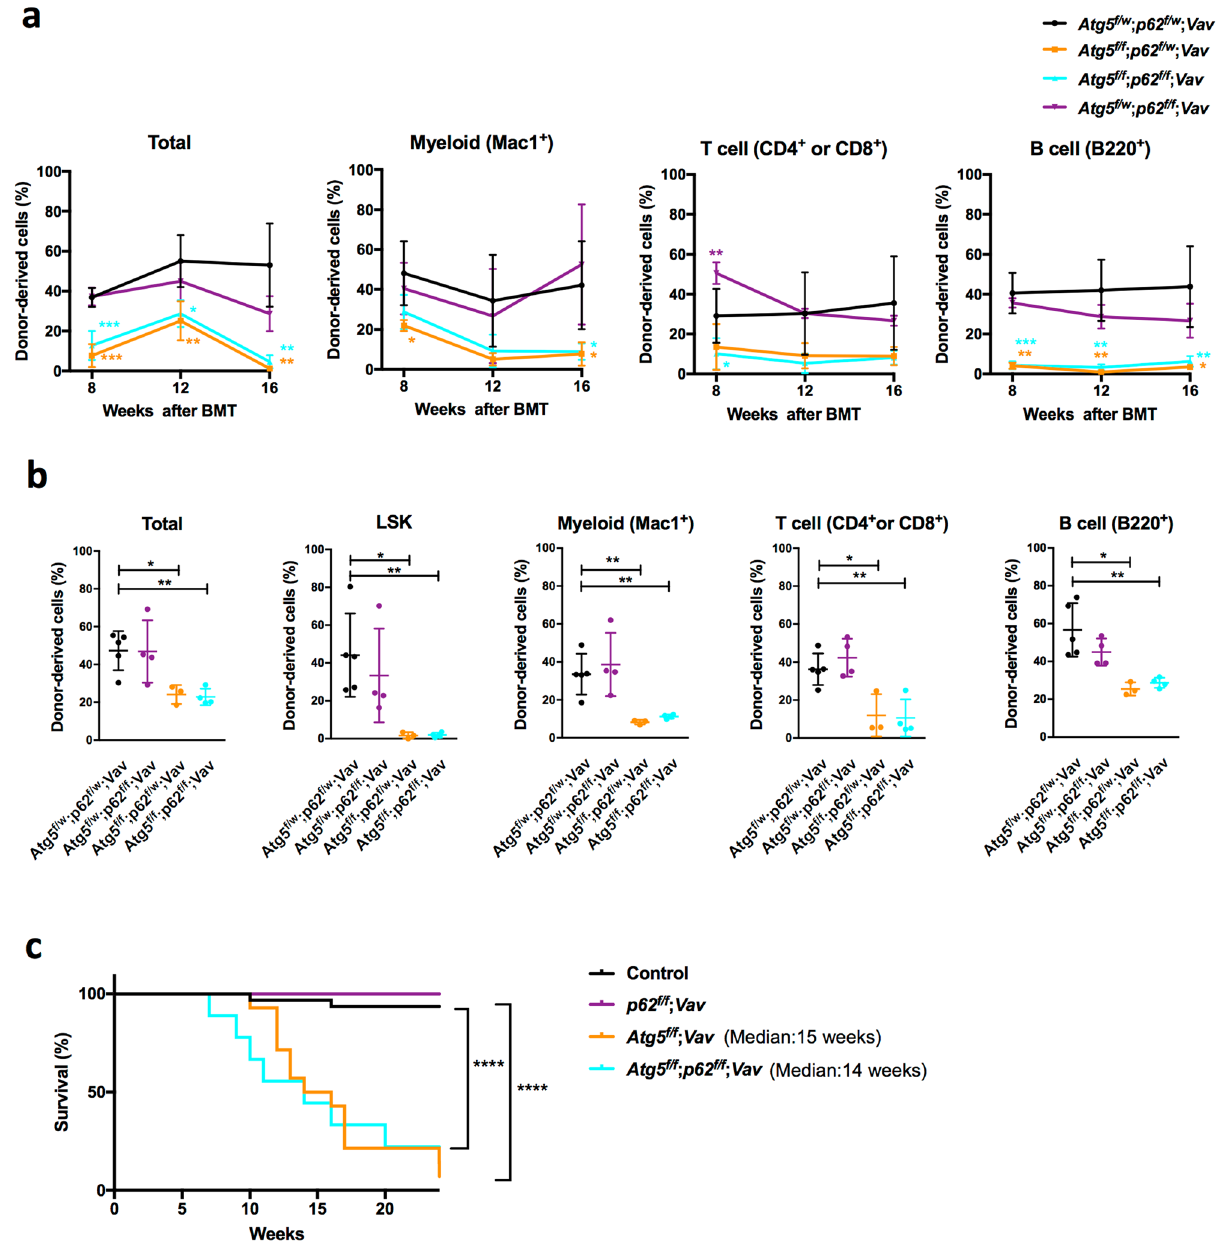
Figure 6. Competitive reconstitution analysis and survival assay. ( a , b ) Competitive reconstitution analysis of BM cells from Atg5 f / w ; p62 f / w ; Vav , Atg5 f / f ; p62 f / w ; Vav , Atg5 f / f ; p62 f / f ; Vav , and Atg5 f / w ; p62 f / f ; Vav mice at 3 weeks. ( a ) Frequencies of donor-derived cells among total cells and lineage cells in PB were analysed 8–16 weeks after transplantation. Data are the mean ± SD (n = 3–5). ( b ) Frequencies of donor-derived cells among total, LSK, myeloid, T, and B cells in BM were analysed 16 weeks after transplantation. Data are the mean ± SD (n = 3–5). Horizontal line indicates the mean of values. ( c ) Survival curve of control (n = 31), p62 f / f ; Vav (n = 6), Atg5V ; Vav (n = 13), and Atg5 f / f ; p62 f / f ; Vav (n = 9)